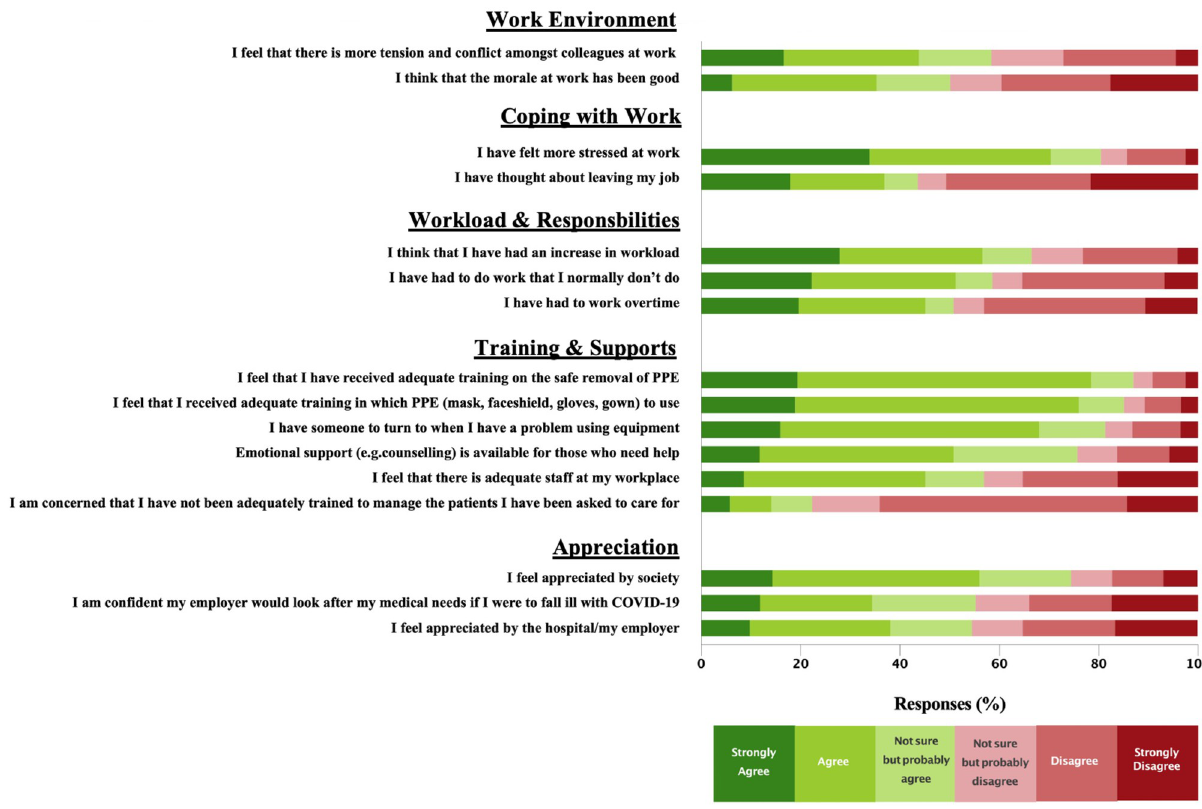
Fig 2. The professional impact of the COVID-19 pandemic on hospital workers.